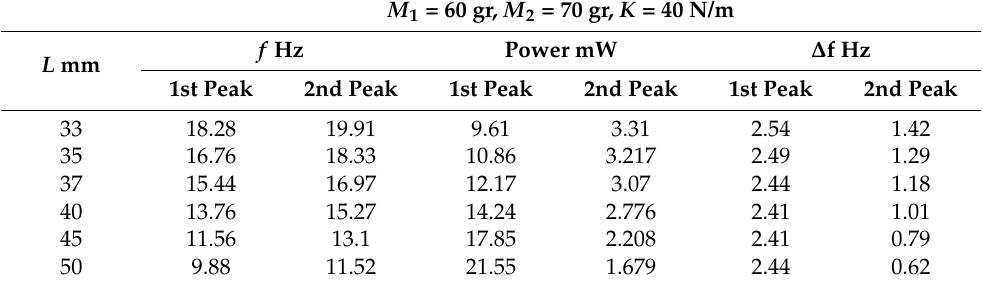
Table A5. The influence of the bimorph length on the output harvested power—two bimorphs interconnected by a spring case.